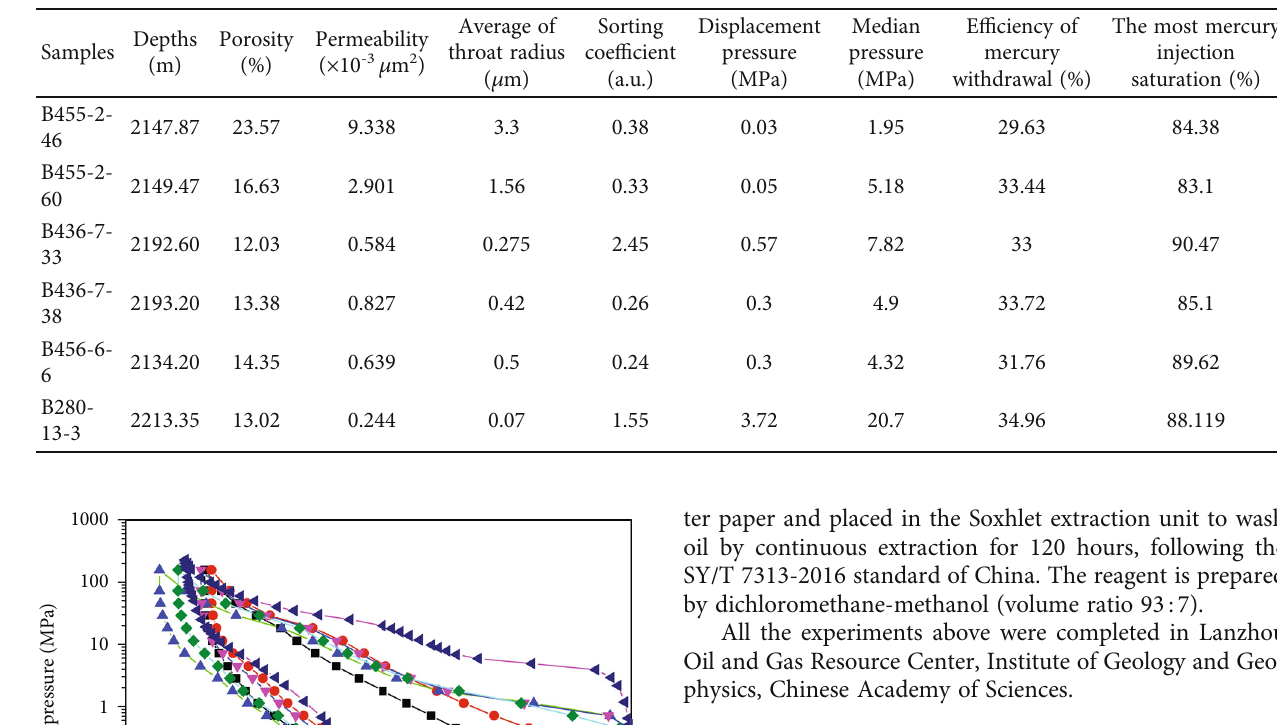
Table 2: Pore structure parameters of HPMI.